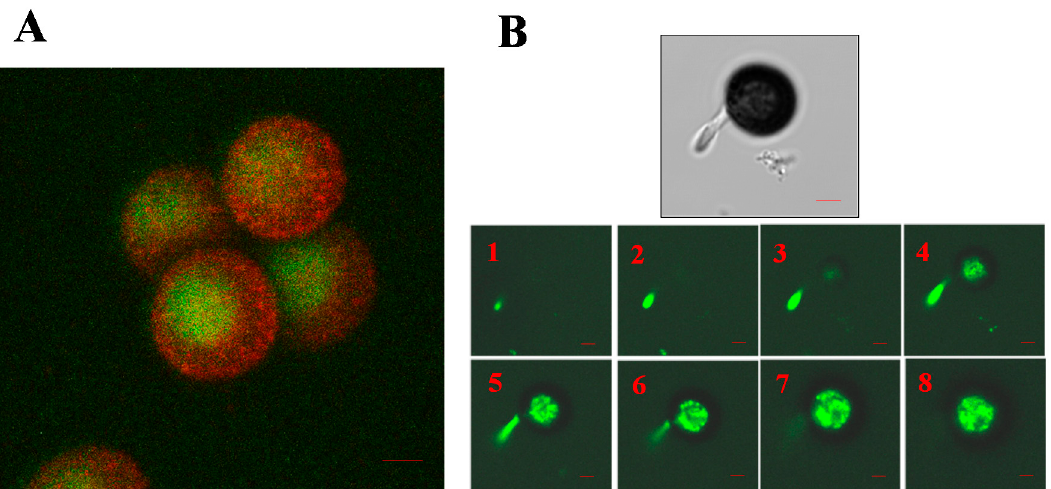
Figure 6. ( A ) Image obtained using confocal microscopy that displays to a group of teliospores. The green color corresponds to Alexa-Fluor ® -488-conjugated phalloidin labeling. The red color corresponds to labeling with an anti-phosphorylated MLC-Ser19 antibody. Scale bars indicate 2 µm. ( B ) Series of images obtained using confocal microscopy that displays a germinating teliospore labeled with Alexa-Fluor ® -488-conjugated phalloidin. Scale bars indicate 2 µm.